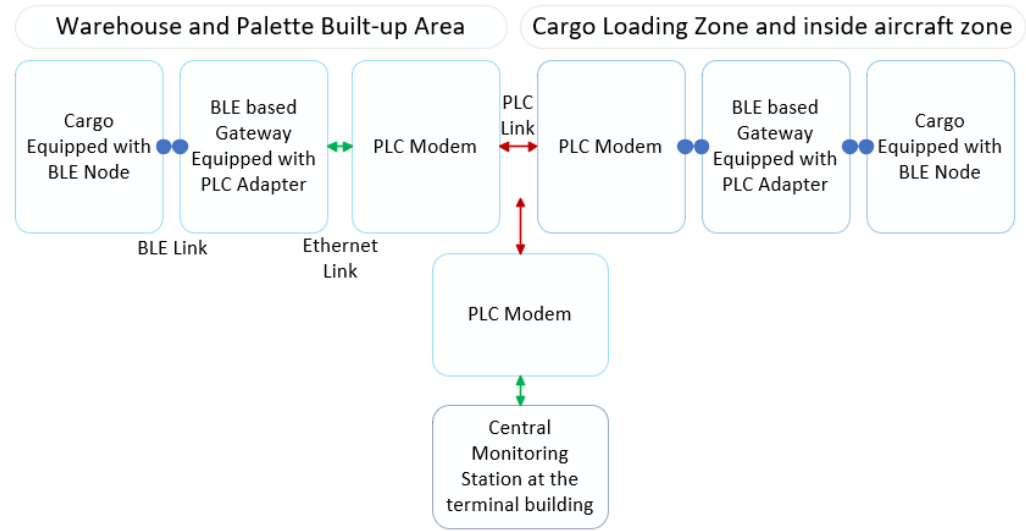
Figure 5. BLE MN Smart Cargo